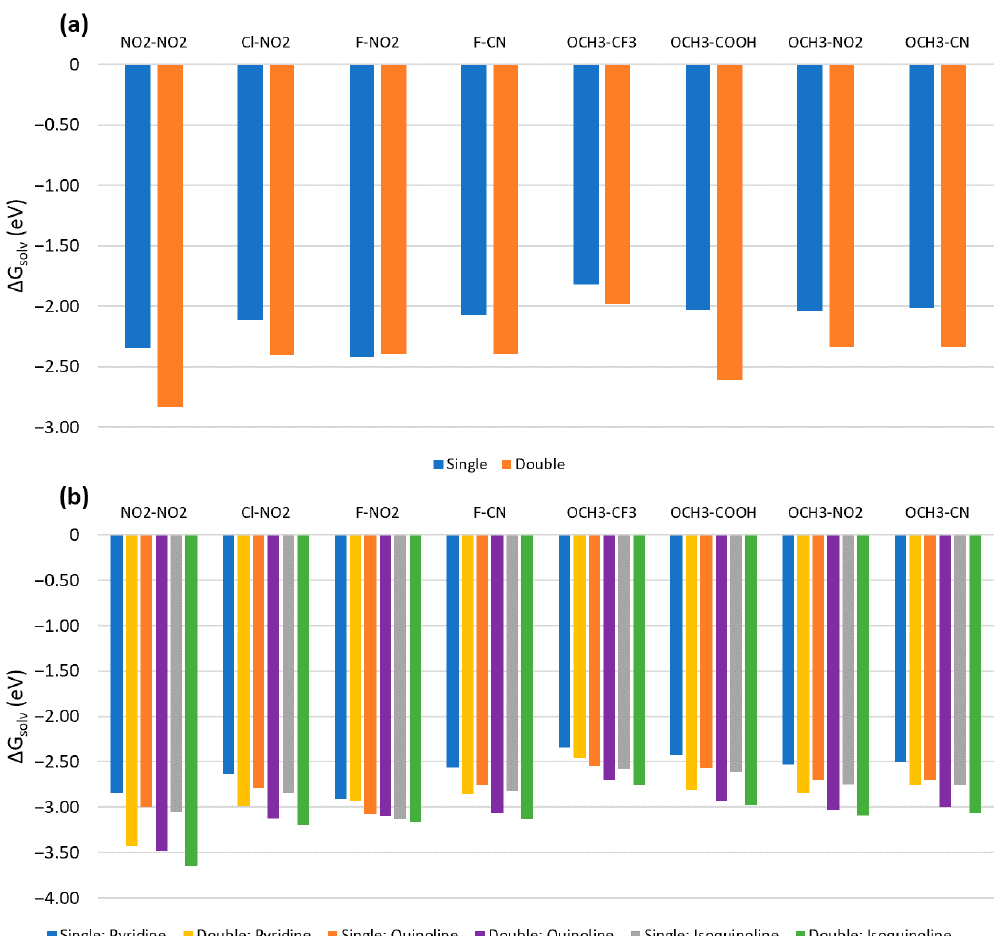
Figure 5. Gibbs free energy of solvation ( ∆ G solv ) calculated using Equation (1) for singly and doubly substituted Cy5 dyes in ( a ) water and ( b ) pyridine, quinoline, and isoquinoline. Singly and doubly substituted Cy5 dyes were made by adding the given substituent pair to the R positions in Figure 1. For doubly substituted Cy5, two of the same substituent were added on the same side of the dye. All calculations were performed using the M06-2X functional.